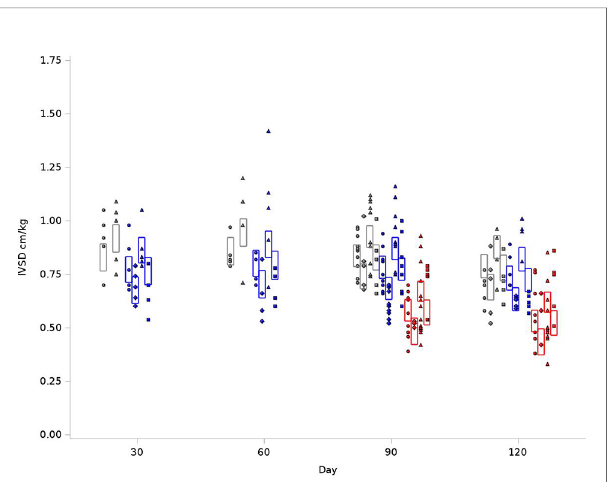
FIGURE 4 | Graphical representation of values for Inter-Ventricular Septum Thickness in Diastole (IVSD) in rats at 4 time points (X-axis). The rats were measured at 4 time points: 30, 60, 90 and 120 days. The values observed are represented by symbols denoting the experimental treatment: Circle (No Radiation and No Lisinopril -R-L), Diamond (No Radiation and Lisinopril -R+L), Triangle (Radiation and No Lisinopril +R-L), or Square (Radiation and Lisinopril +R+L). The colors represent the strain: Brown-Norway (BN: black), Salt- Sensitive (SS: blue) and SS with BN chromosome 6 (SSBN6: red). The rectangles are 95% Con fi dence Intervals for IVSD from a Repeated Measures linear model for treatment that included time, and strain. IVSD values were normalized to body weight. Radiotherapy increased IVSD by 11-16% at 120 days (p=0.0001) in all rats and lisinopril mitigated this effect by decreasing the IVSD by 12-17% (p < 0.0001).